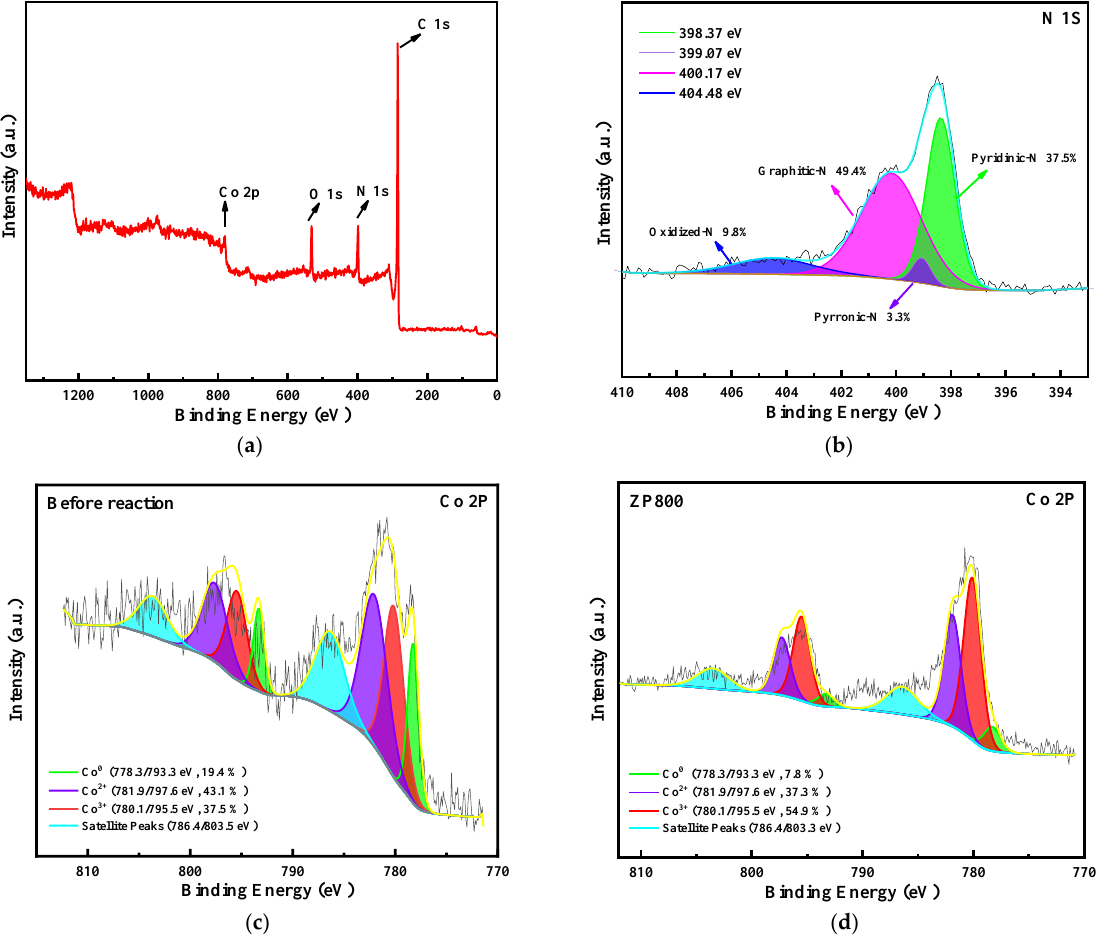
Figure 5. The wide-range XPS spectrum ( a ), N 1s spectrum ( b ) and Co 2p spectrum ( c ) of ZP600; ( d ) Co 2p spectrum of ZP800.